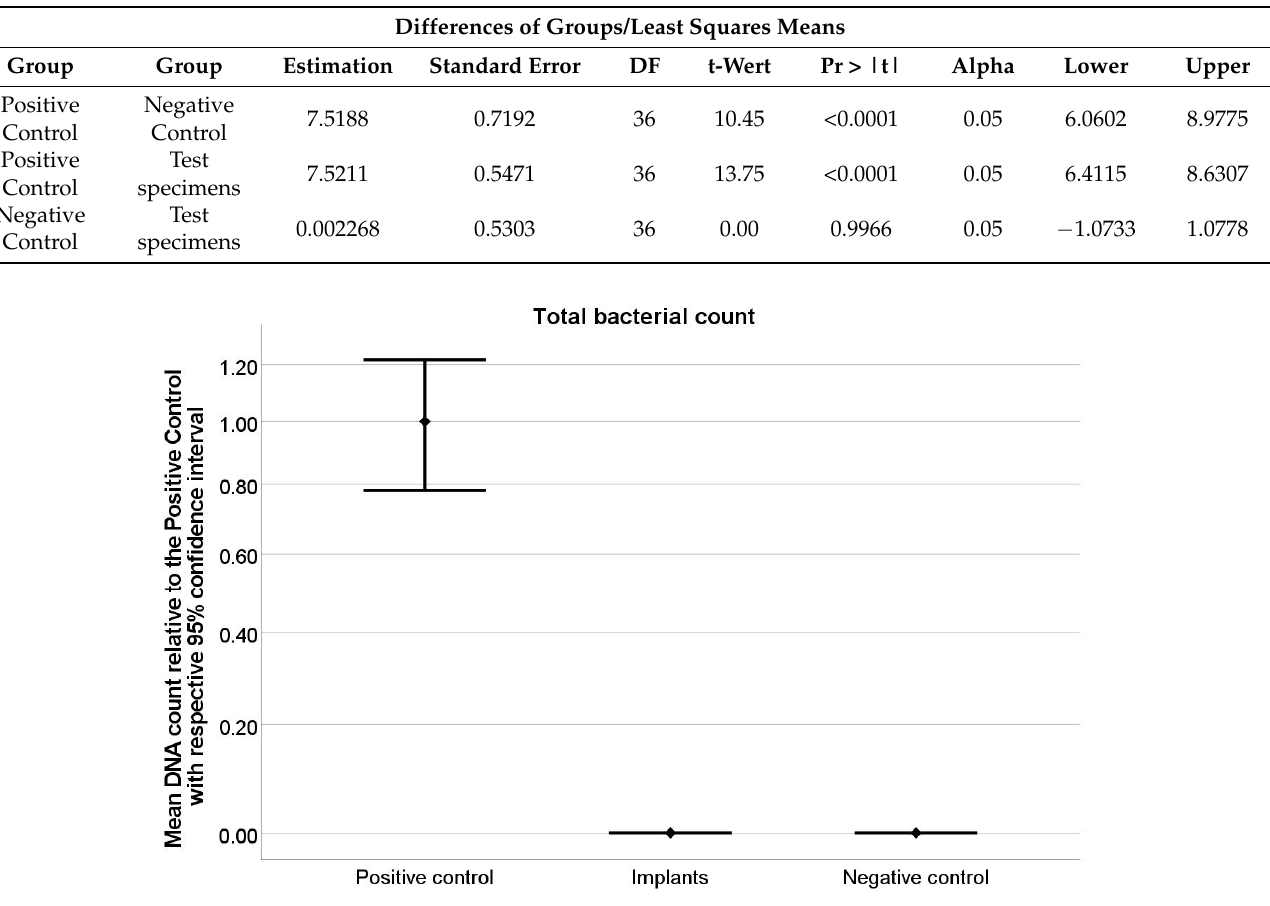
Figure 2. Graphical illustration of the statistical results in Table 2, which is based on the statistical qrt-PCR amplification results for positive controls ( n = 4—four amplification values per positive control), negative controls ( n = 4—four amplification values per positive control) and implant specimens ( n = 16—two amplification values per implant). A significant difference of qrt-PCR results between the positive control and test groups ( p < 0.001) and no difference between the negative control and test groups ( p = 0.99) could be shown. Table 3. While the comparison of test and control group had a significant effect on the results of bacterial growth ( p < 0.001), statistical analysis revealed no significant difference for the mean bacterial count at different test days ( p = 0.69).